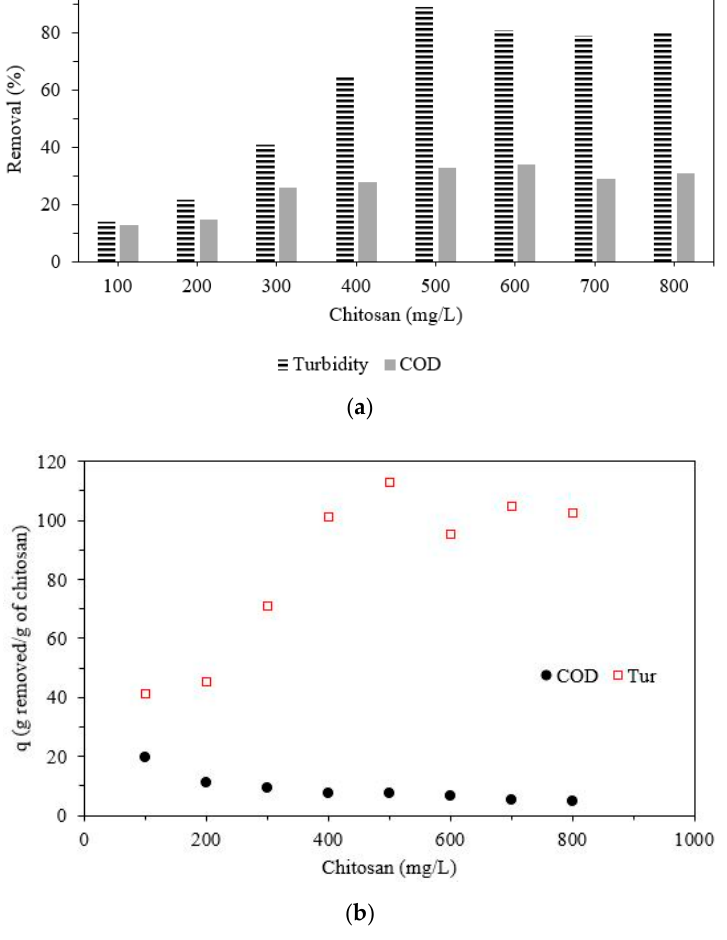
Figure 1. Coagulation/flocculation optimization tests results in terms of percentage removal ( a ) and of chemical oxygen demand/turbidity (COD/Tur) g removed/g of chitosan used ( b ) (temperature = 25 °C, initial pH = 4.6, initial COD = 12.24 g L − 1 , initial turbidity = 3.89 g L − 1 ).